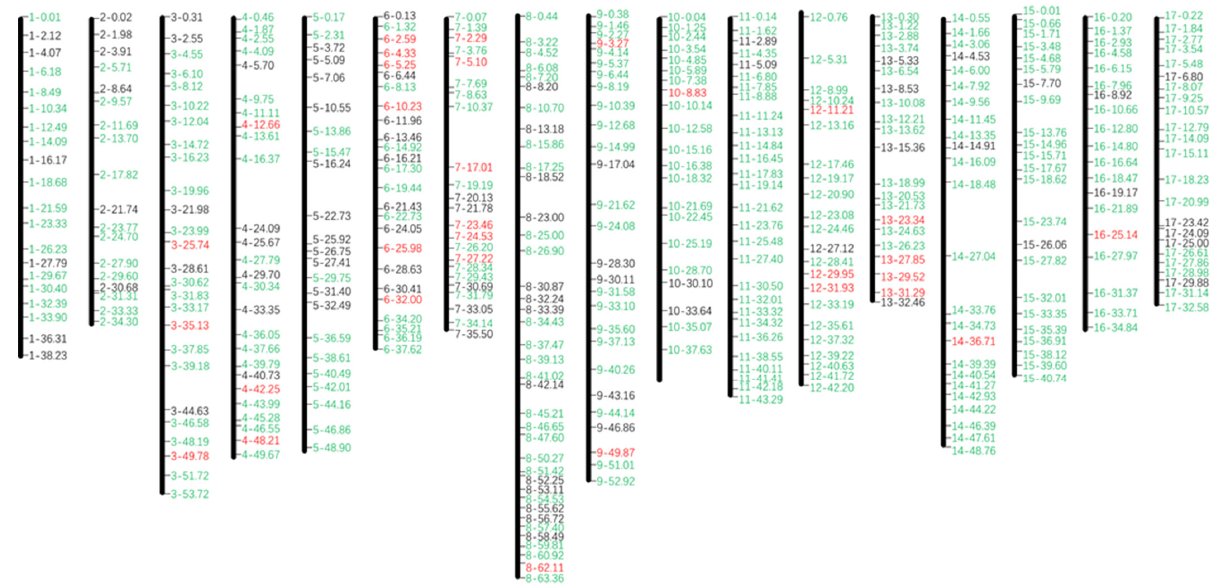
Figure 3. The physical map of 407 InDel markers distributed across all 17 chromosomes of G. paniculata genome. The name code of the InDel marker was presented as a chromosome number with the physical distance. Green markers discriminate alleles between WT-P and WT-W. Red markers amplified close bands on gel, and black markers were unavailable. Table 1. The successful rates of InDel markers for all 17 chromosomes.